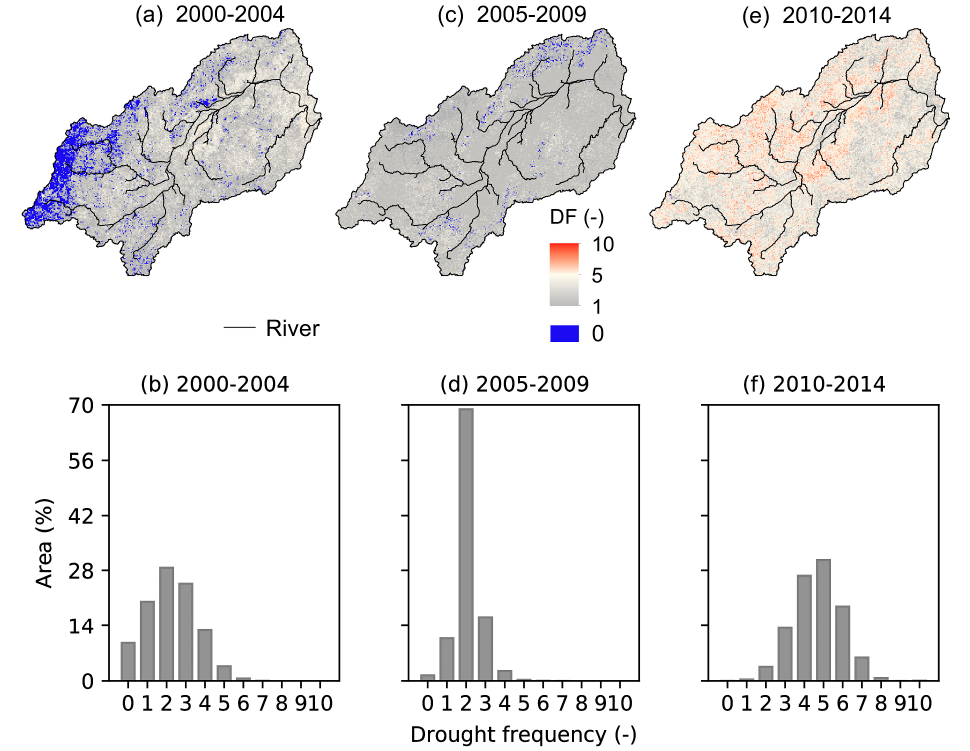
Figure 5. Map ( a ) and histogram ( b ) of drought frequency (DF) during the first quinquennium. Map ( c ) and histogram ( d ) of DF during the second quinquennium. Map ( e ) and histogram ( f ) of DF during the third quinquennium.